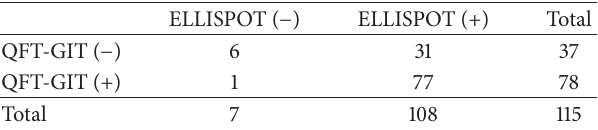
Table 2: Correspondence between two IGRAs.